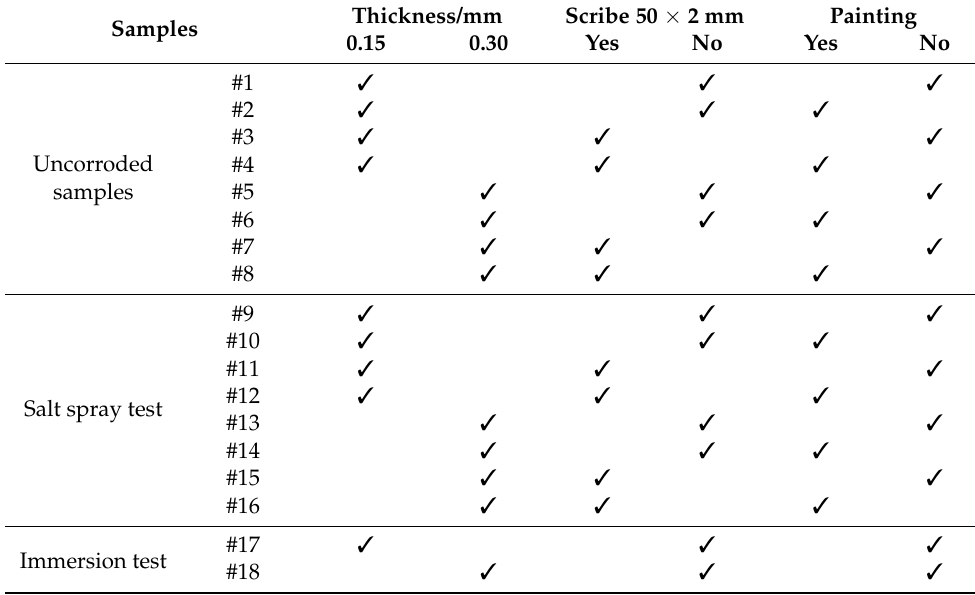
Table 1. Samples involved in the test and their corresponding details.